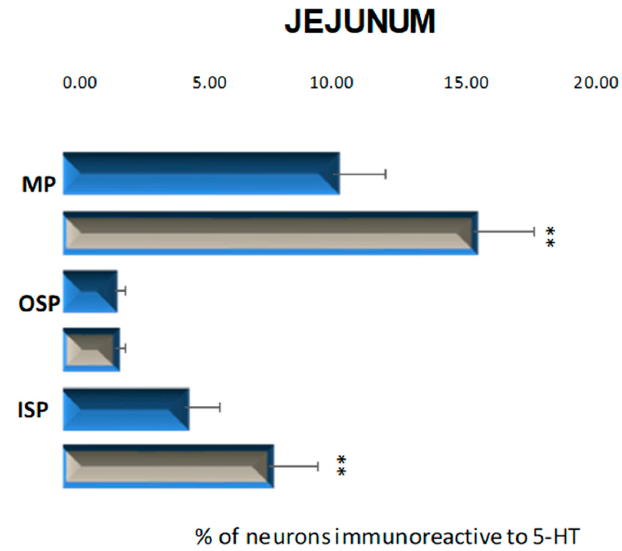
Figure 5. Schematic diagram of the proportion of perikarya immunoreactive to 5-HT of the control (blue bars) and experimental group (grey bars) in the particular parts of jejunum. MP—the myenteric plexus; OSP—the outer submucosal plexus; ISP—the inner submucosal plexus. ** p < 0.01 indicates differences between all groups for the same neuronal population.